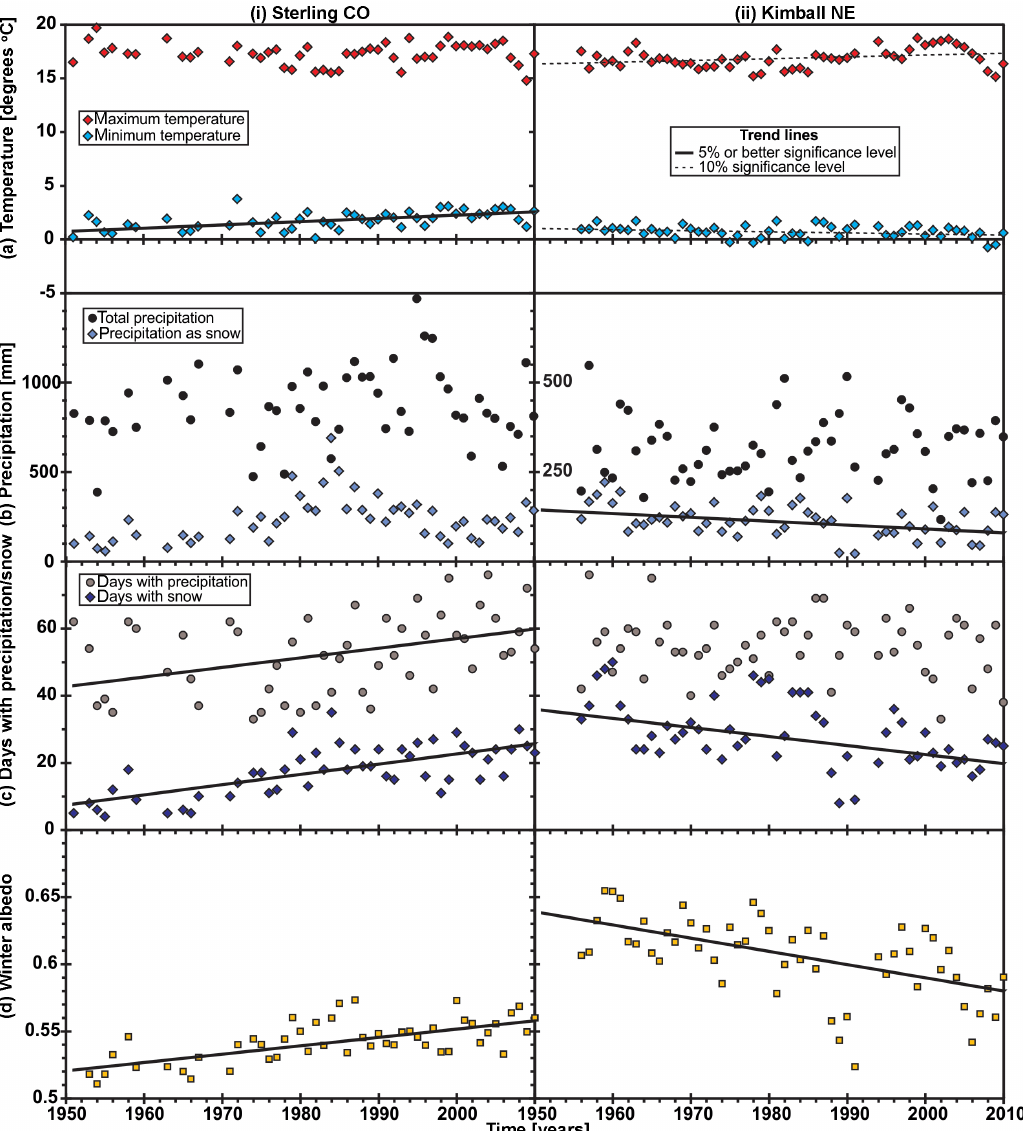
Figure 4. Time series of climate at the neighbouring (i) Sterling, Colorado, and (ii) Kimball, Nebraska, meteorological stations, illustrating (a) temperature (annual maximum and minimum), (b) total annual precipitation and precipitation as snow, (c) days with precipitation and days with snowfall, and (d) winter albedo. Significant trends are shown as solid lines for the p < 0.05 level and as dashed lines for the p < 0.10 level. The Kimball station is 73km northwest of the Sterling